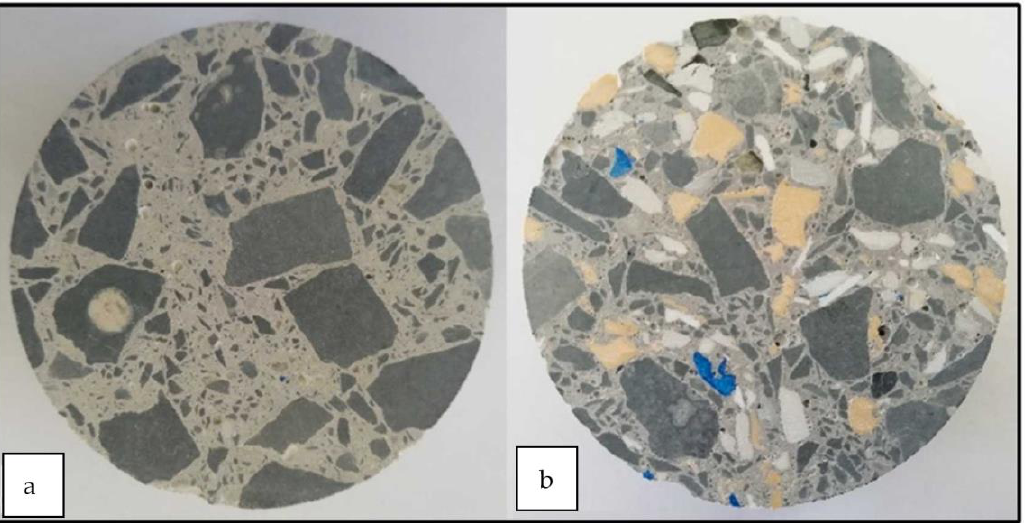
Figure 22. Exposed surfaces of the concrete disc ( a ) without WEEE (Control mix) and ( b ) with 30% WEEE (PC-Blend-30). Reprinted with permission from ref. [64].